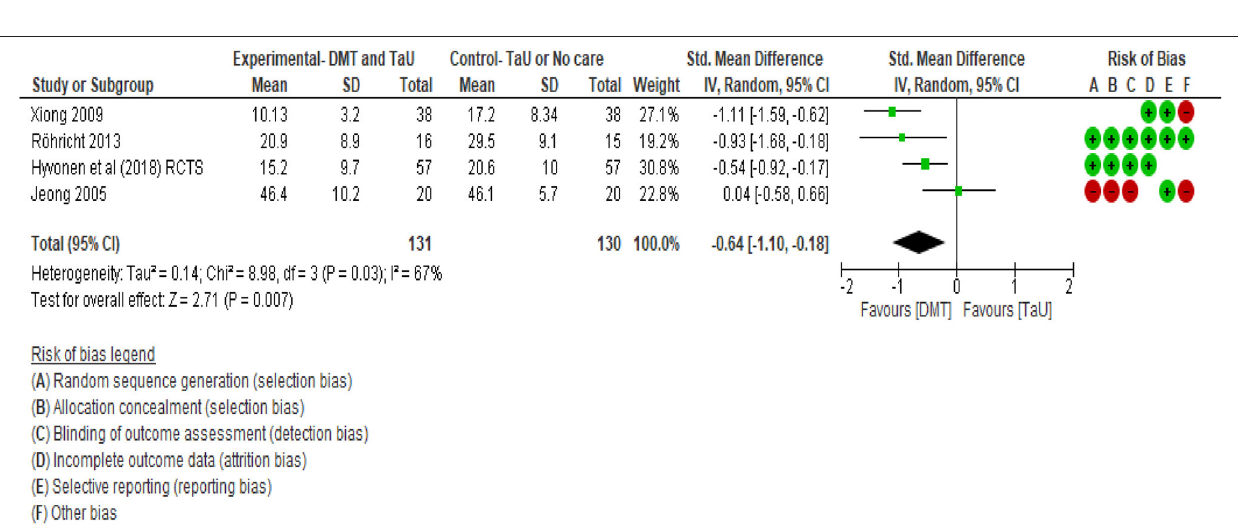
FIGURE 8 | Between Groups—RCTs (post DMT vs.